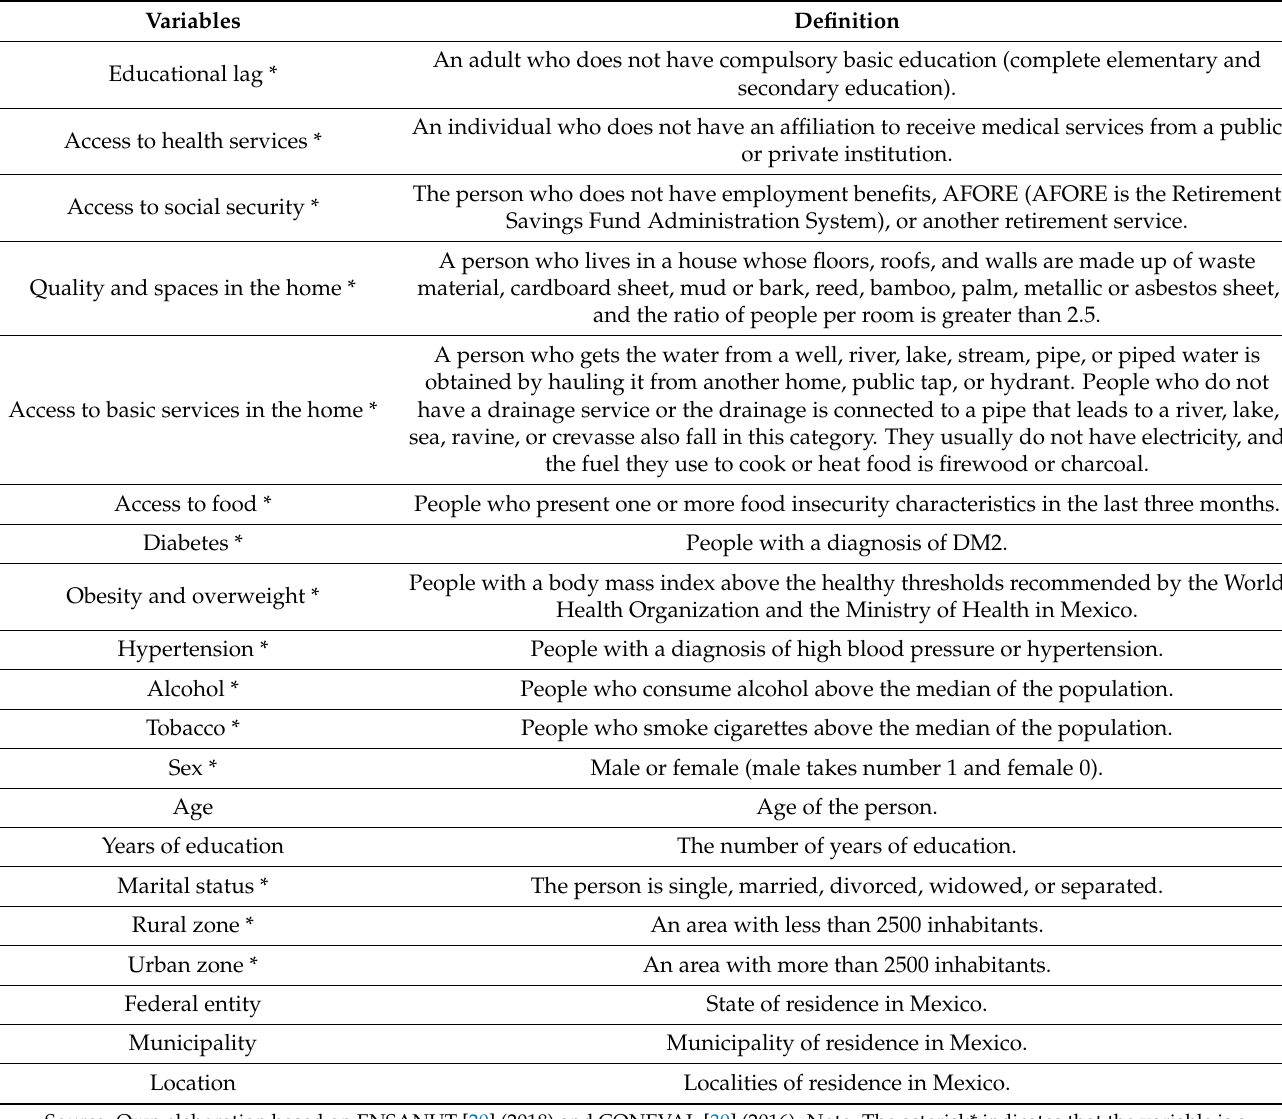
Table A1. Variables and definitions used in this study